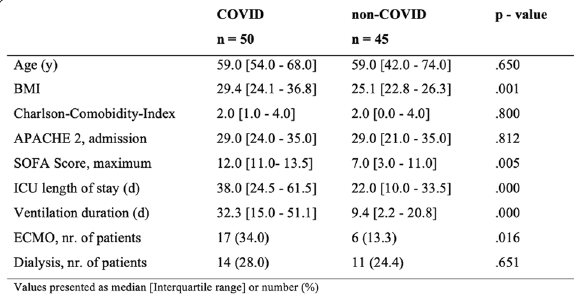
Figure 1. Demographic and clinical characteristics of the